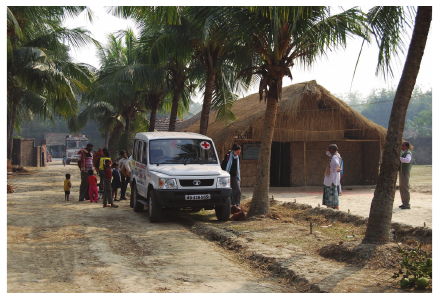
Figure 3: Screening day for noncommunicable diseases in a rural village. The screening took place in the local school (on the right side of the figure), managed by IIMC (Institute for Indian Mother and